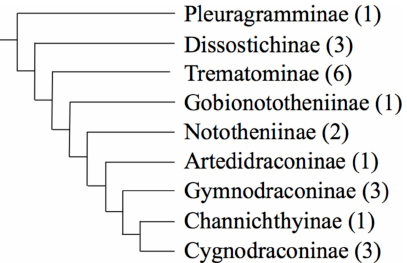
Figure 1. Phylogenetic relationships (cladogram) of the nototheniid sub-families presented in this study (as defined in [63]). Total number of genera for each nototheniid sub-families are indicated in parenthesis. Genera used in this study: Pleuragramma (Pleuragramminae), Dissostichus (Dissostichinae),